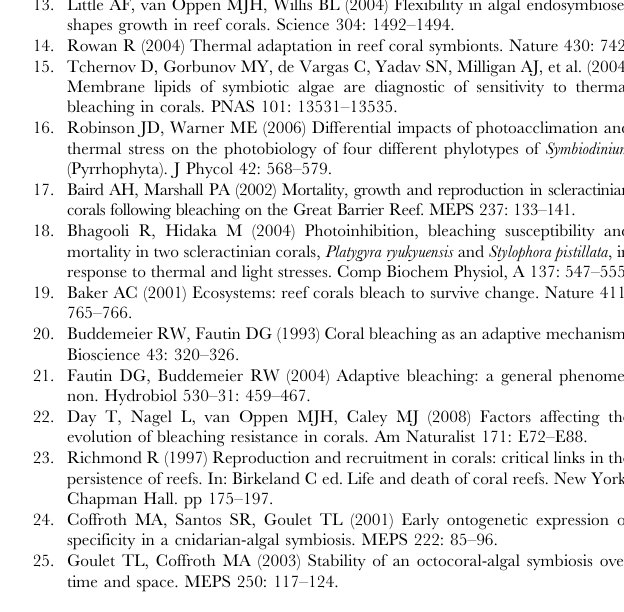
Figure S1 SSCP profiles of the six Symbiodinium types used for tank inoculations. Top line = Symbiodinium type, M= Marker of reference ITS1 sequences. C2* was found to be a mix of types C2* and A.